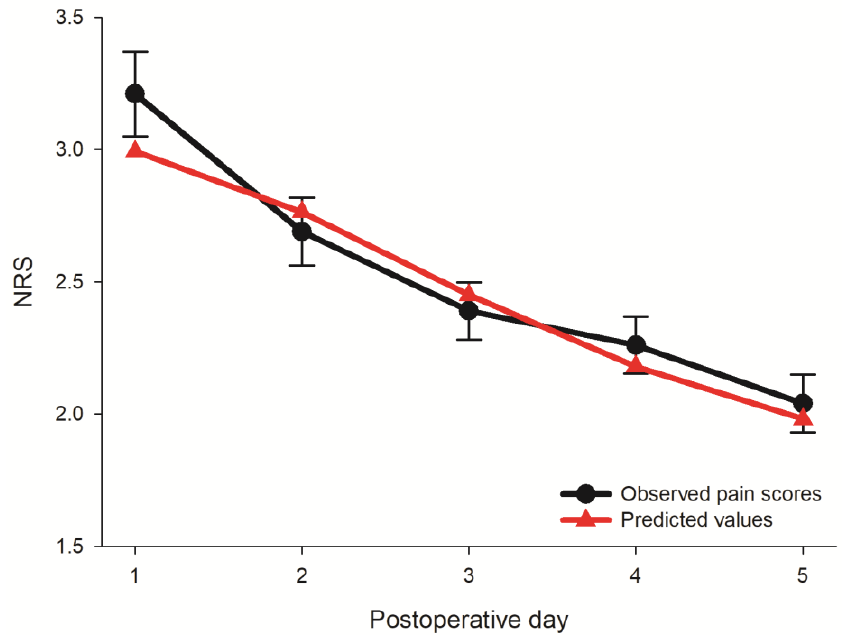
Figure 2. The observed maximal pain scores with their standard deviations and predicted values of the basic latent curve model after surgery for renal cell carcinoma.